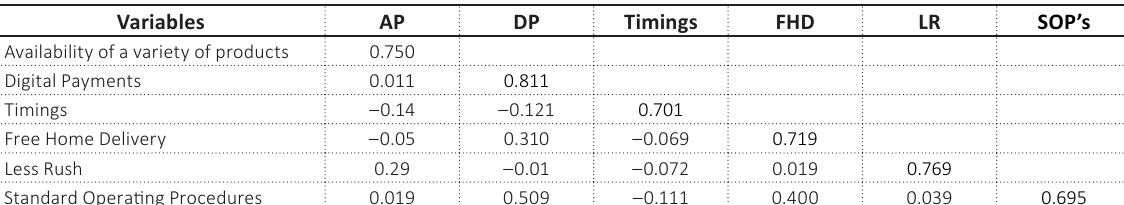
Table 4. Reliability and